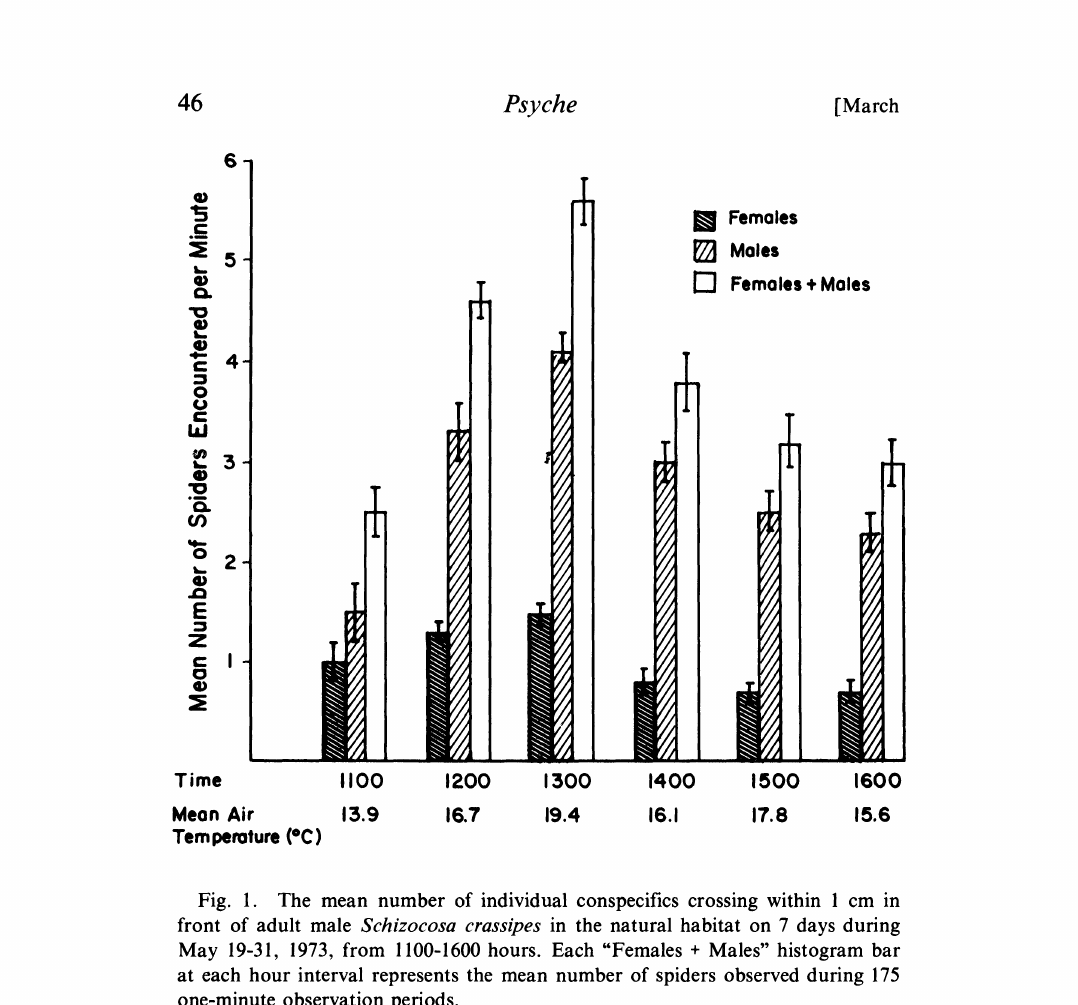
Fig. 1. The mean number of individual conspecifics crossing within cm in front of adult male Schizocosa crassipes in the natural habitat on 7 days during May 19-31, 1973, from 1100-1600 hours. Each "Females + Males" histogram bar at each hour interval represents the mean number of spiders observed during 175 one-minute observation